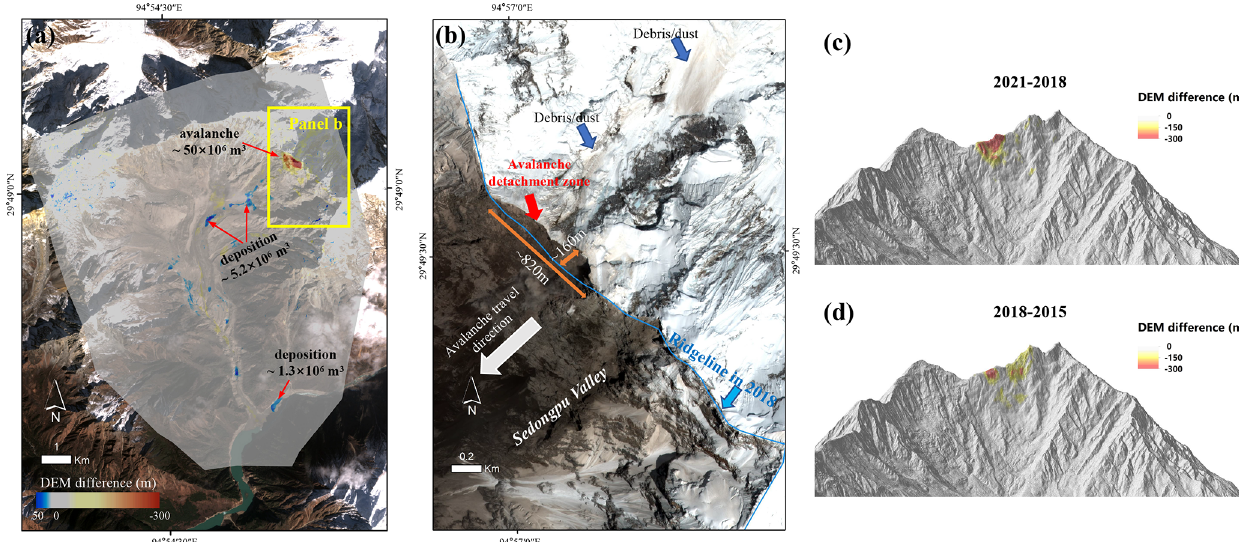
Figure 2. Elevation change across the wider Sedongpu basin derived from Pléaides imagery dated 30 December 2018 and 30 April 2021 (a) . The close-up Pléiades image on 30 April 2021 showing the headward migration of the mountain ridgeline due to mass loss associated with the March 2021 ice-rock avalanche (b) . Oblique three-dimensional comparison of source regions and magnitudes of the massive ice-rock avalanches in 2021 and 2017 near the north ridge of Gyala Peri peak (c, d) .